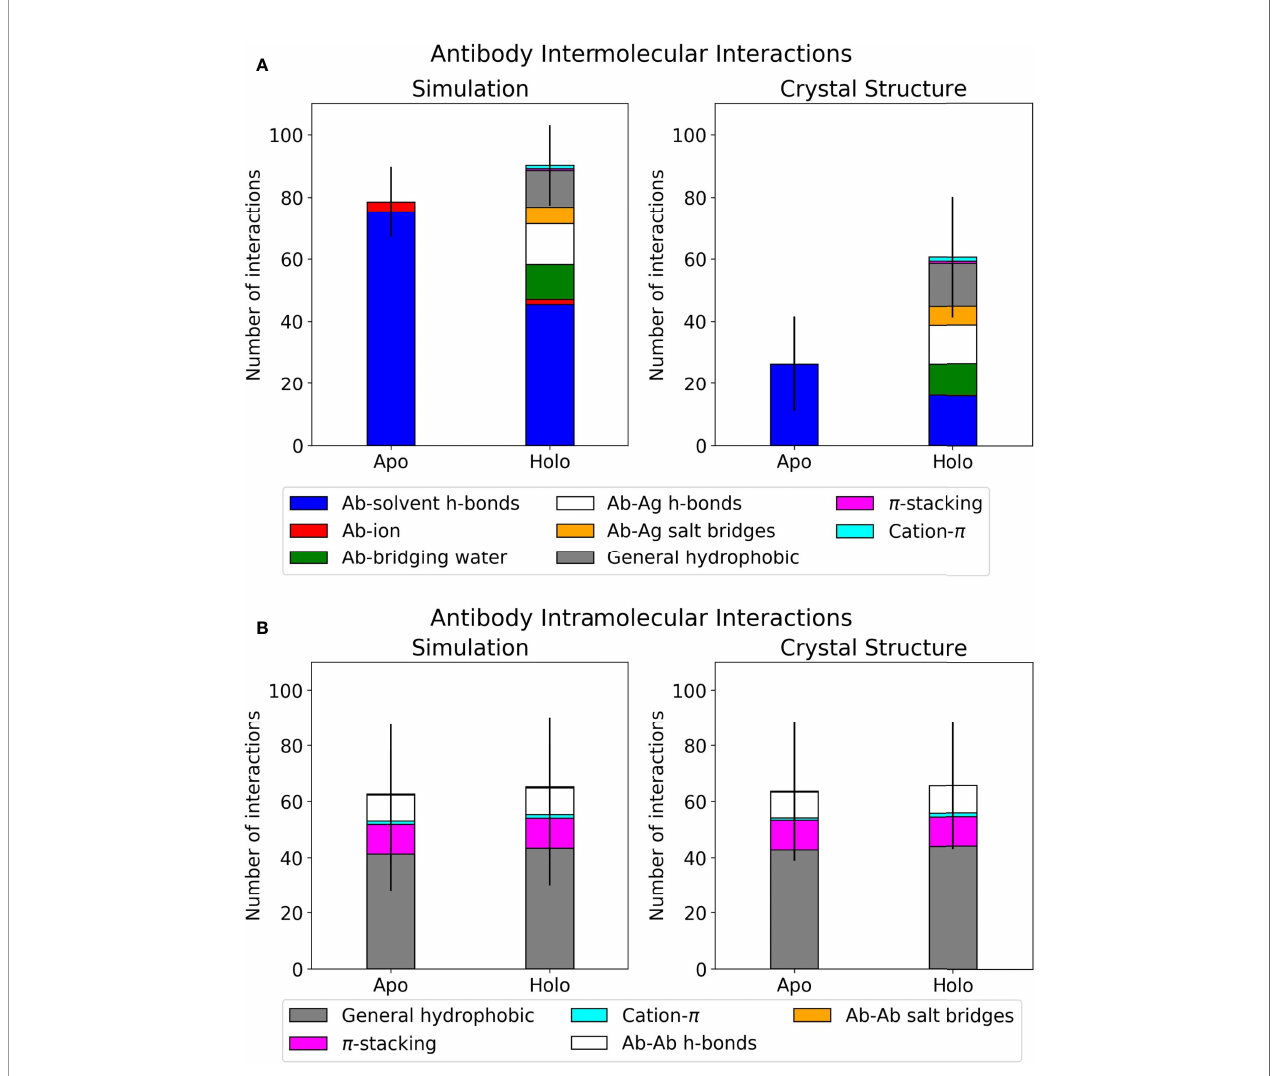
FIGURE 1 | Interface interactions of the antibody-antigen dataset. Error bars show one standard deviation of the mean total. Graphs for individual antibodies are in Supplementary Figure 1 . (A) Mean intermolecular interactions for REST2 simulations and crystal structures. (B) Mean intramolecular interactions for REST2 simulations and crystal